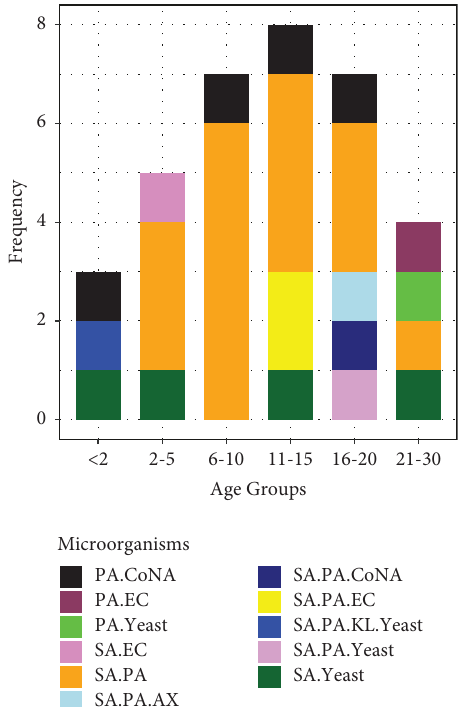
Figure 1: Distribution of coinfection patterns within diferent age groups. SA, Staphylococcus aureus ; PA, Pseudomonas aeruginosa ; KL, klebsiella spp ; EC, Escherichia coli ; E.spp, Enterobacter spp ; CoNA, coagulase negative staphylococci; AX, Achromobacter